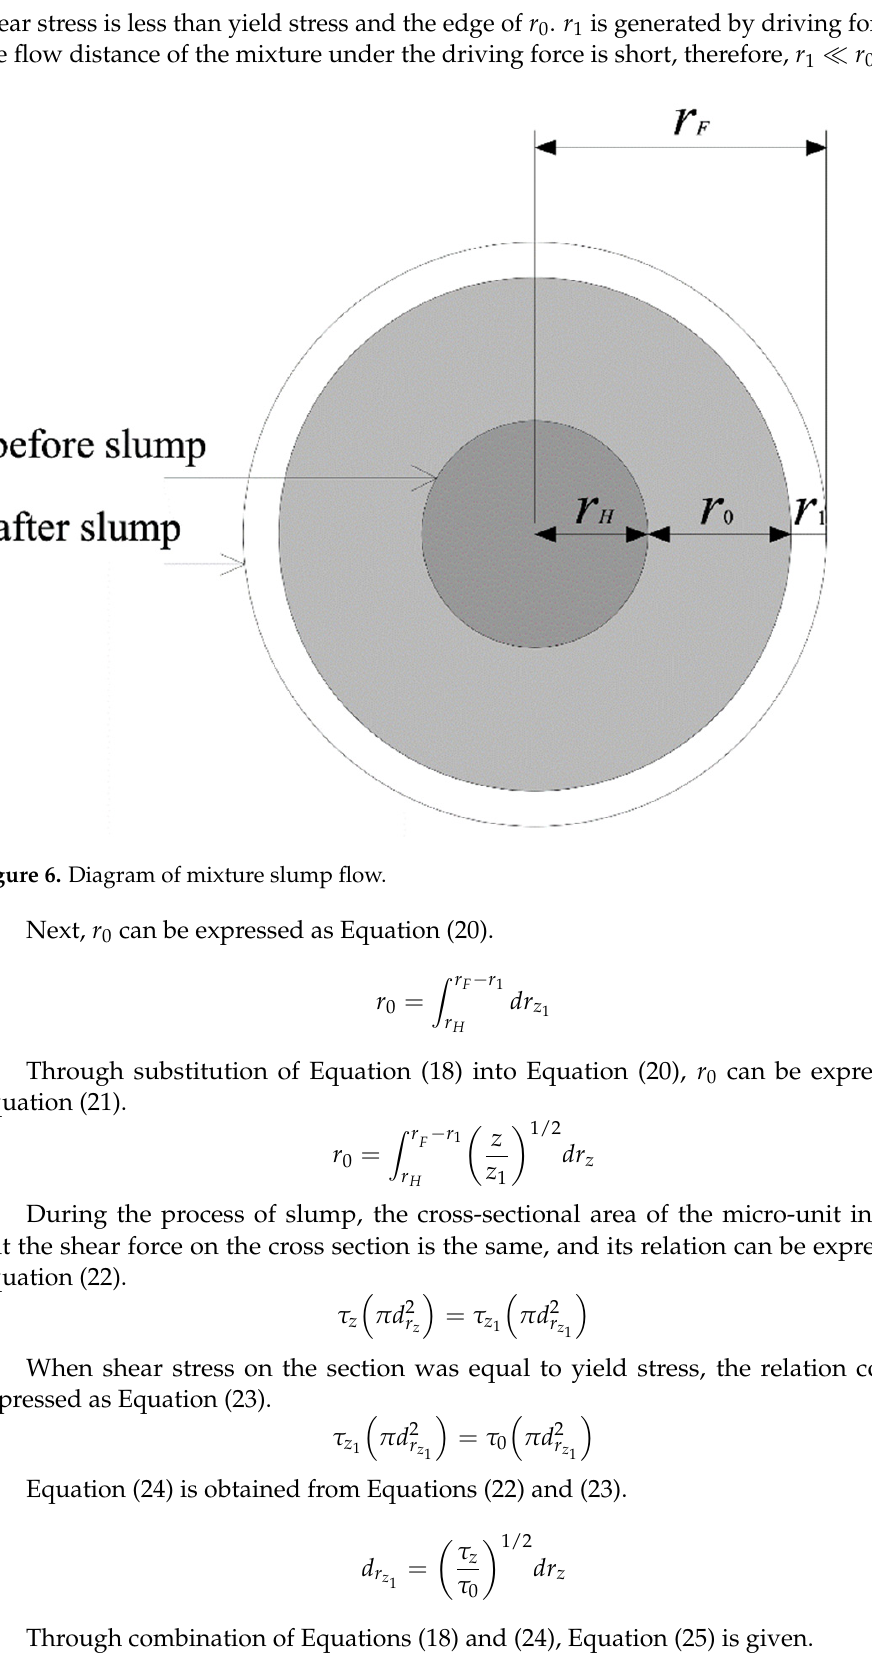
Through combination of Equations (18) and (24), Equation (25) is